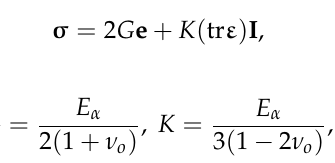
Figure 7. Mortar creep test vs. predictions of the standard model with three sets of parameters. The constitutive relationship of isotropic linearly elastic materials is as follows: